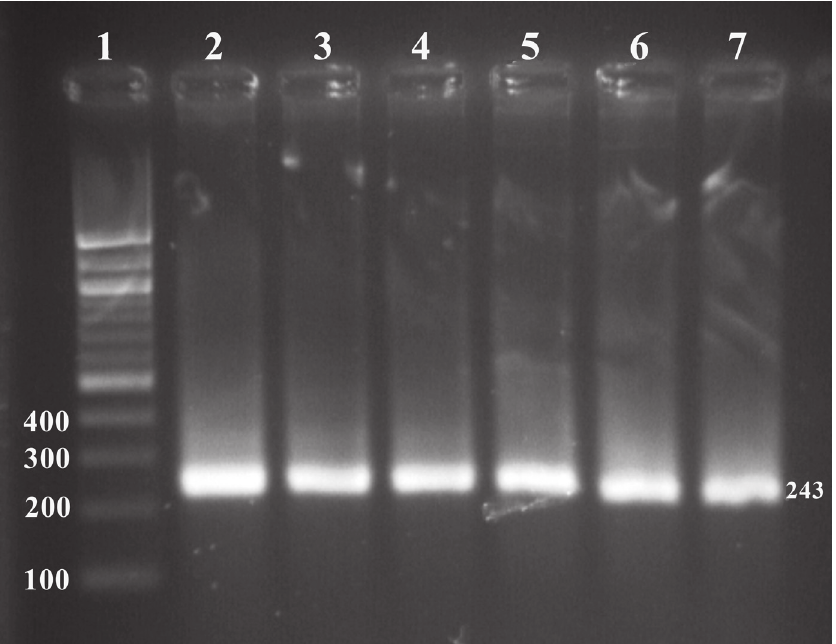
Figure 2. Gel electrophoresis of RT-PCR products of Plum pox virus (PPV) with specific primers. Lane 1, molecular marker 100 bp (MBI); lane 2–5, different PPV apricot isolates (2, Ankara; 3, Konya; 4 and 5, Kayseri); lane 6–7, PPV plum isolates (both from